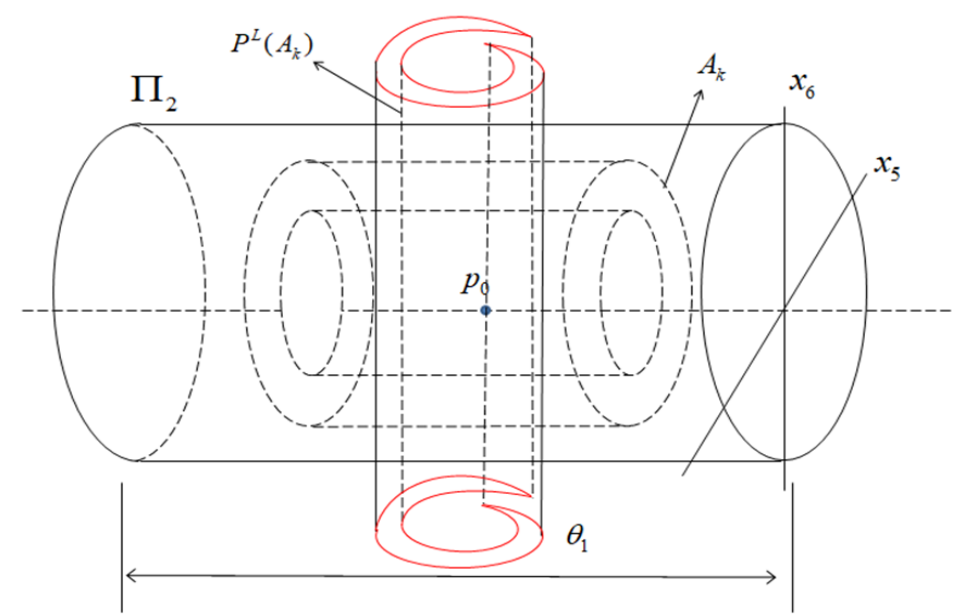
Figure 12. The four-dimensional Poincare map.